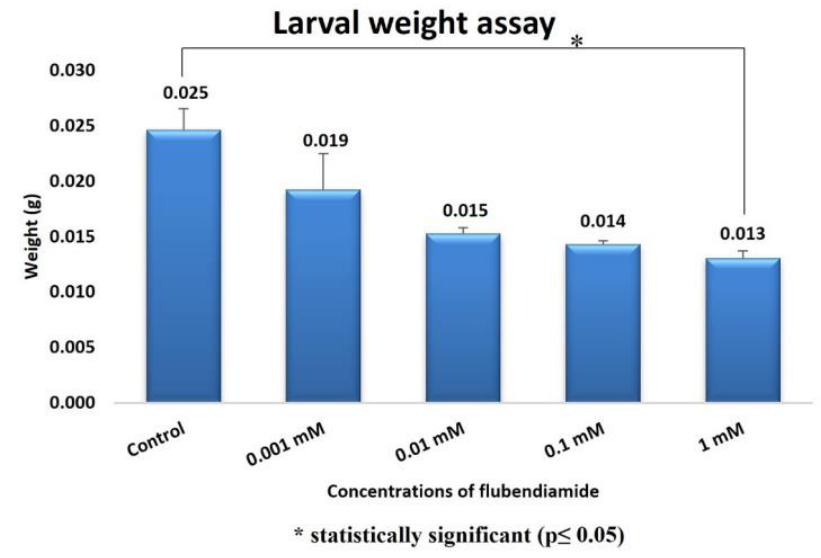
Figure 7. Effect of FLB exposure on larval weight of D. melanogaster.